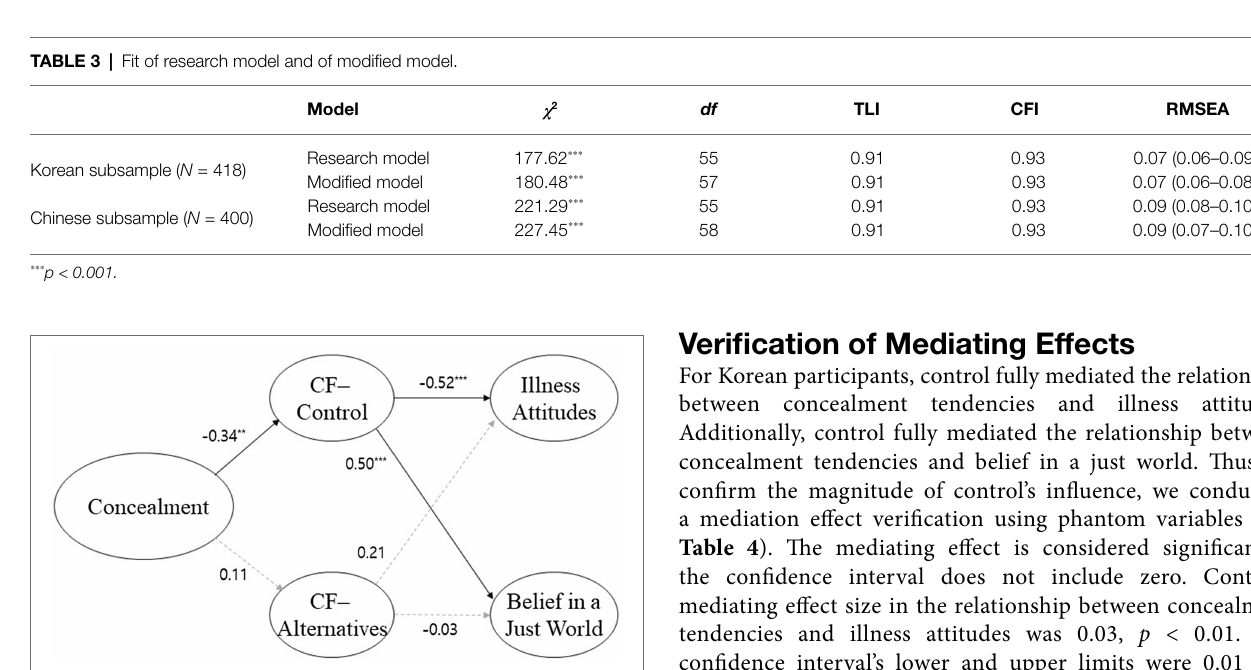
FIGURE 2 | Verified Structural Model for Korean Subsample.